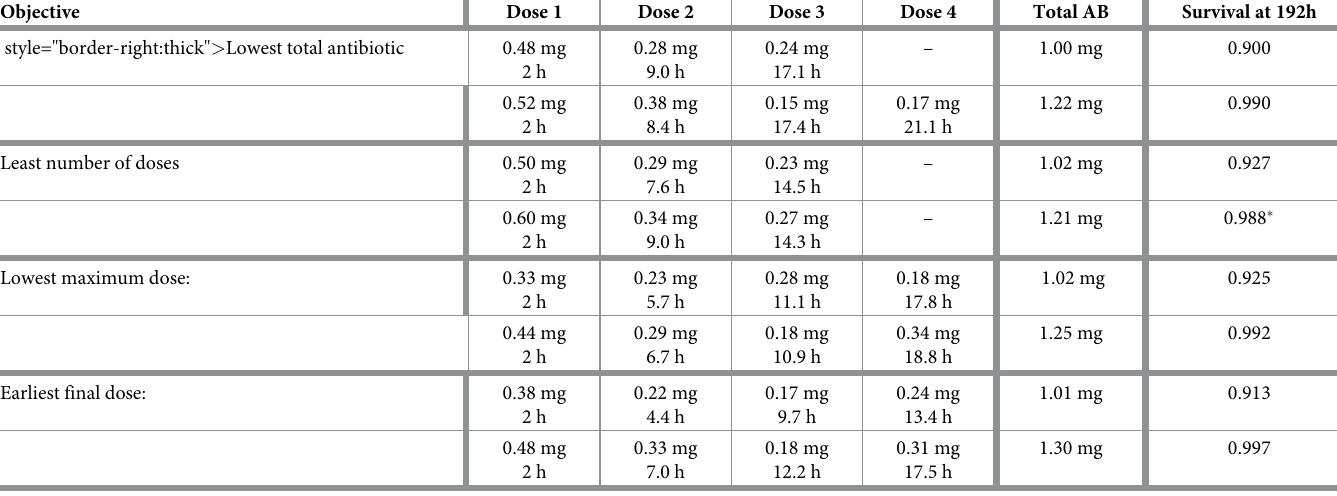
Table 4. Optimal treatment regimens from within the Pareto Front (Fig 5B) for different criteria, given host survival at 192 h of at least (a) 0.9, or (b) 0.99. ( � Only 4-dose treatments were found along the upper edge of Pareto Front with host survival more than 0.99).